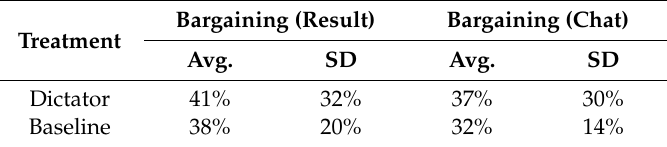
Table 2. Bargaining game results in share of tokens kept by the strong